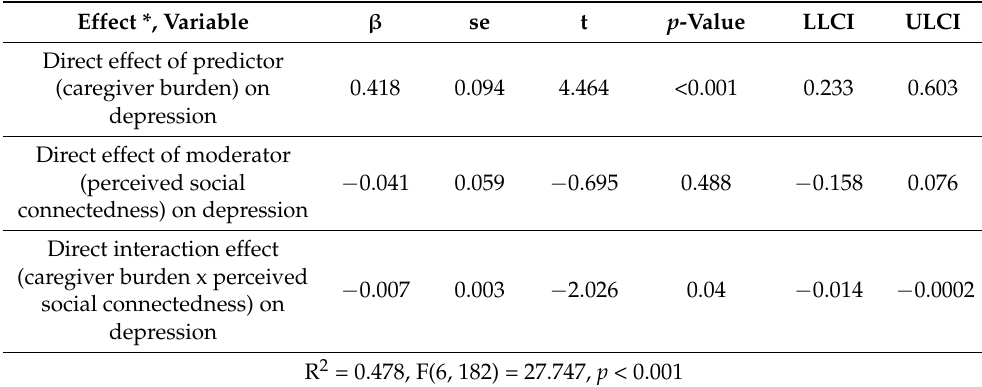
Table 4. Results from the test of the moderation model of social